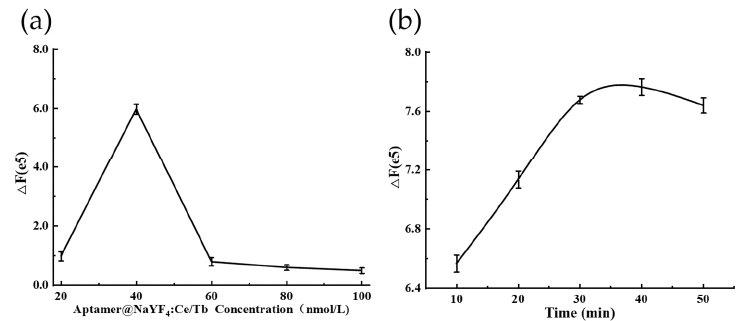
Figure 2. ( a ) Fluorescence recovery values of histamine at different Aptamer@NaYF 4 :Ce/Tb con- centrations. ( b ) Fluorescence recovery value of Aptamer@NaYF 4 :Ce/Tb after different periods of reaction with histamine.